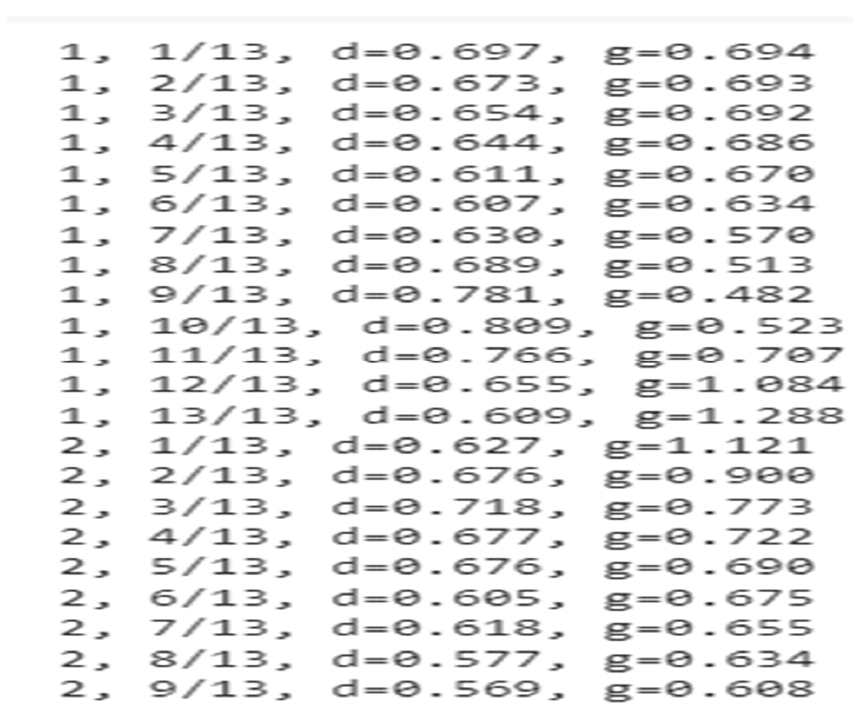
Figure 6. Combined summary for the GAN model.